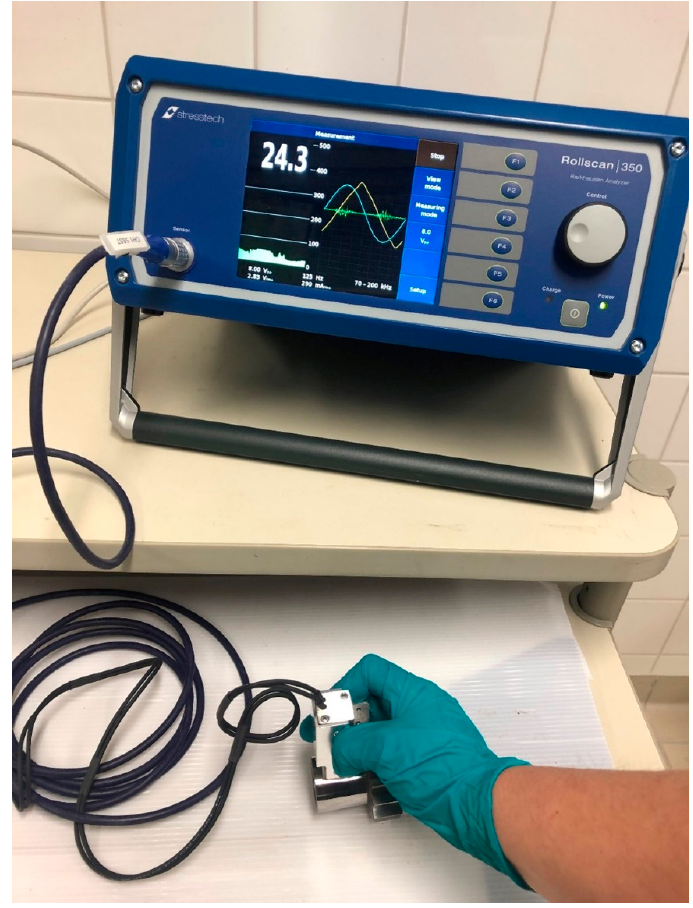
Figure 1. Barkhausen noise measurement set up.